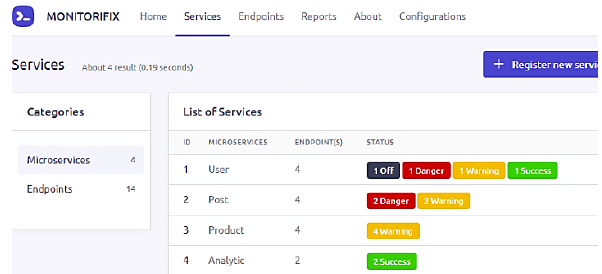
Figure 10. Main Display of Dashboard for Monitoring Microservices